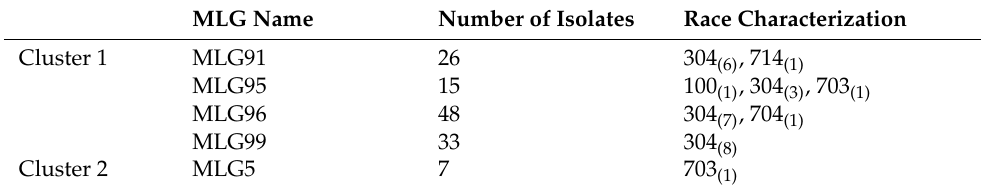
Table 4. Details of identical multilocus genotypes (MLG) among the genetic clusters. The five genotypes repeated more than five times are listed by cluster membership; the name of the MLG is denoted by a number, with the number of times it was observed in the full dataset, and in which races. Where the same genotype was found in more than one race, the number of samples for each race is given next to the race name in